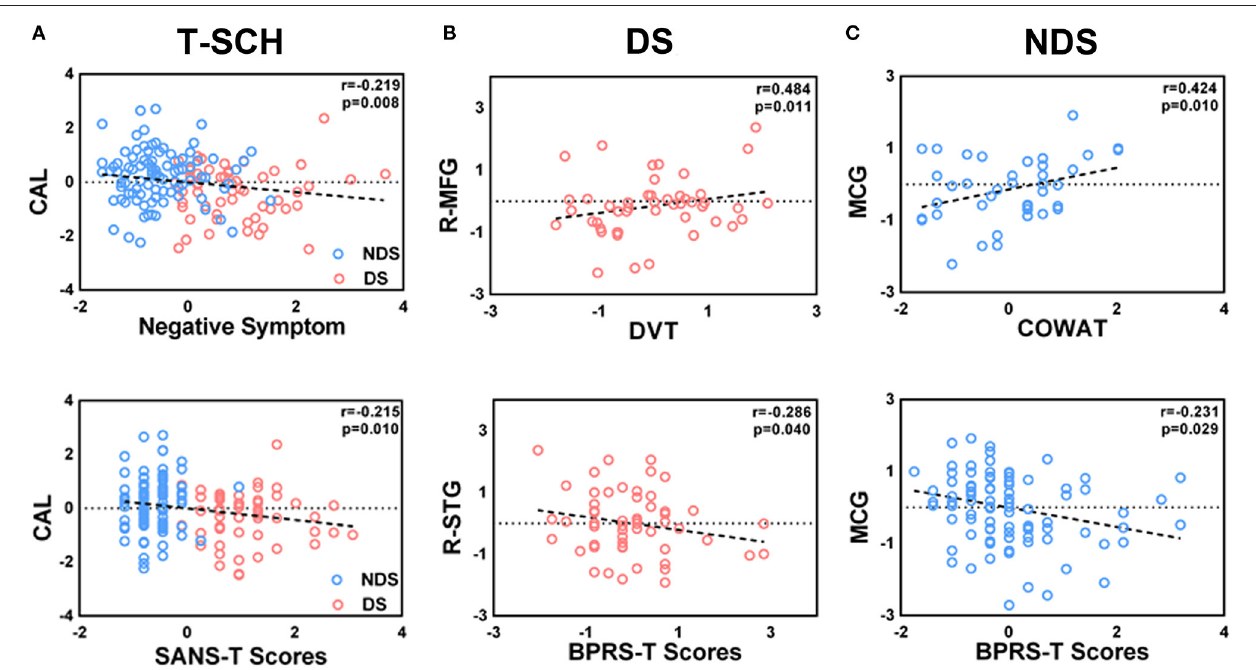
FIGURE 3 | (A–C) Significant correlations between the altered FC of left NAcc network with clinical features and neurocognitive assessments in total patient group, DS group and NDS group. The significant threshold was set at p < 0.05 (uncorrected). FC, Functional Connectivity; T-SCH, Total Schizophrenia Patients; DS, Deficit Schizophrenia Patients; NDS, Non-Deficit Schizophrenia Patients; CAL, Calcarine; R-MFG, Right Middle Frontal Gyrus; R-STG, Right Superior Temporal Gyrus; MCG, Middle Cingulate Gyrus; DVT, Digit Vigilance Test; COWAT, Controlled Oral Word Association Test; SANS-T, Scale for the Assessment of Negative Symptoms; BPRS-T, Brief Psychiatric Rating